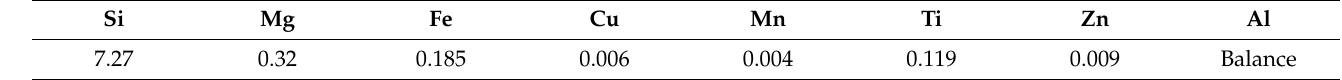
Table 1. A commercial A356 alloy matrix composition by weight fraction